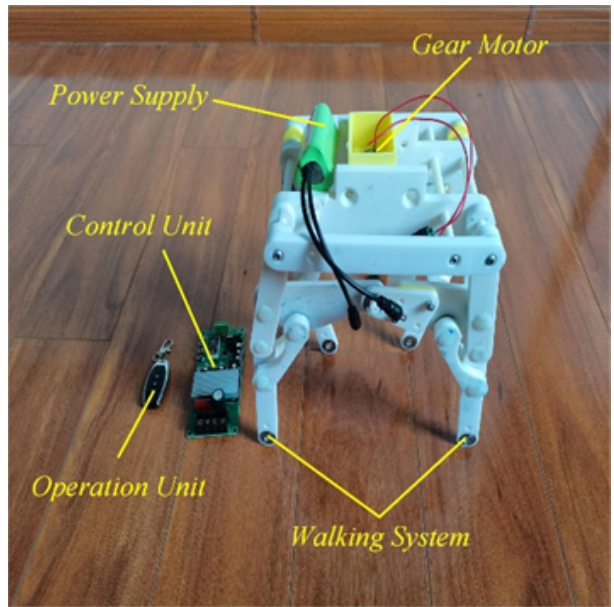
Figure 16. Experimental